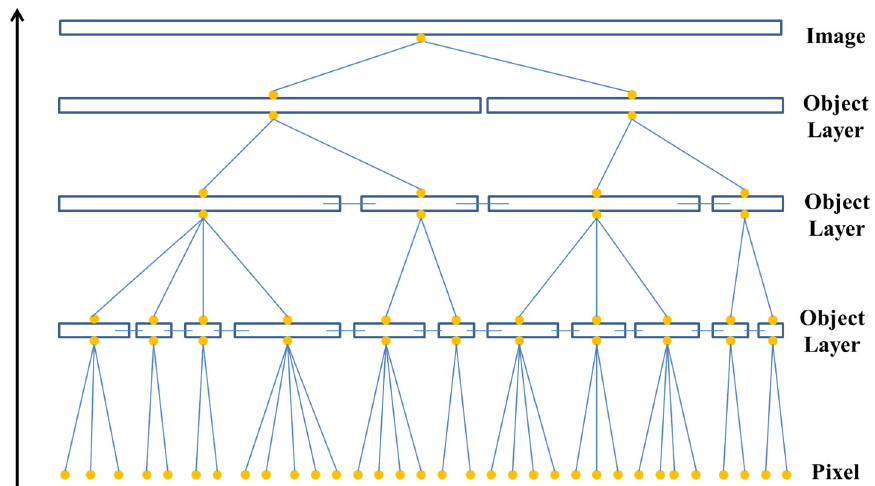
Figure 6. Multi-scale segmentation.